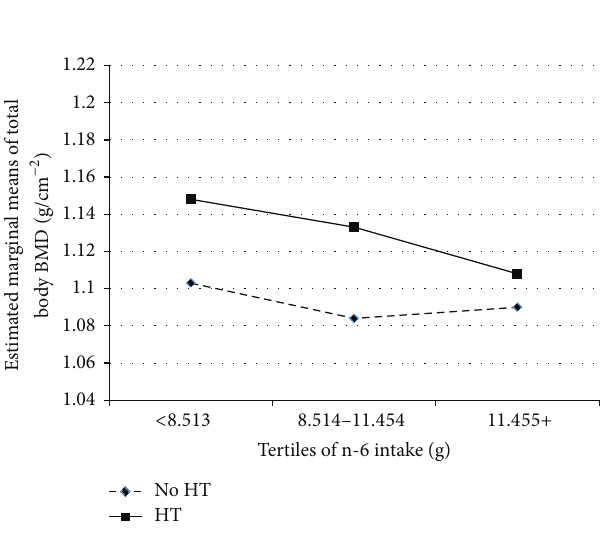
Figure 1: Associations of n-6 with total body BMD (g/cm 2 ). Figure 2: Associations of n-3 with total body BMD (g/cm 2 ). Covariates included energy intake, calcium intake, iron intake, years after menopause, and